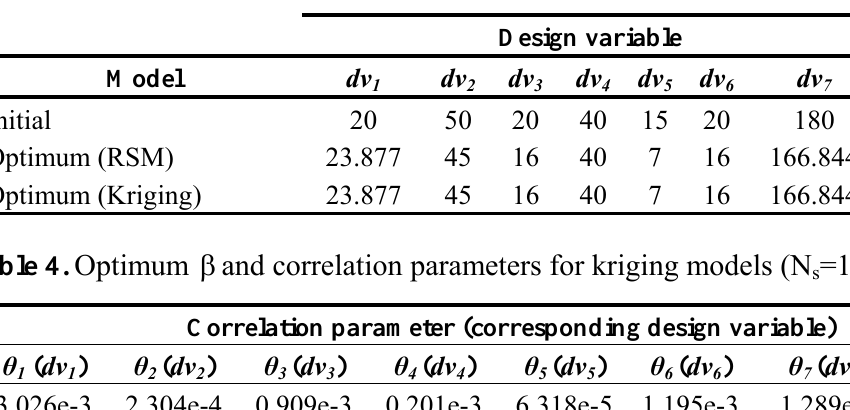
Table 3. Optimum level and size.